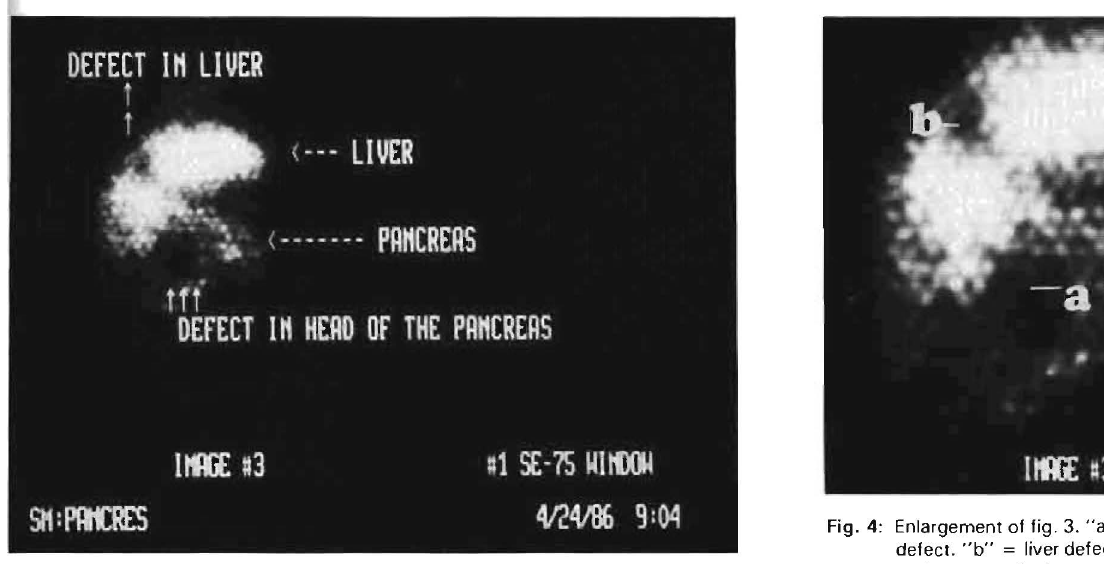
Fig. 4: Enlargement of fig. 3. "a" = pancreas defect. "b" = liver defect. "a" correspond to the tumour in the pancreas and "b" correspond to themetastatic tumour in the liver